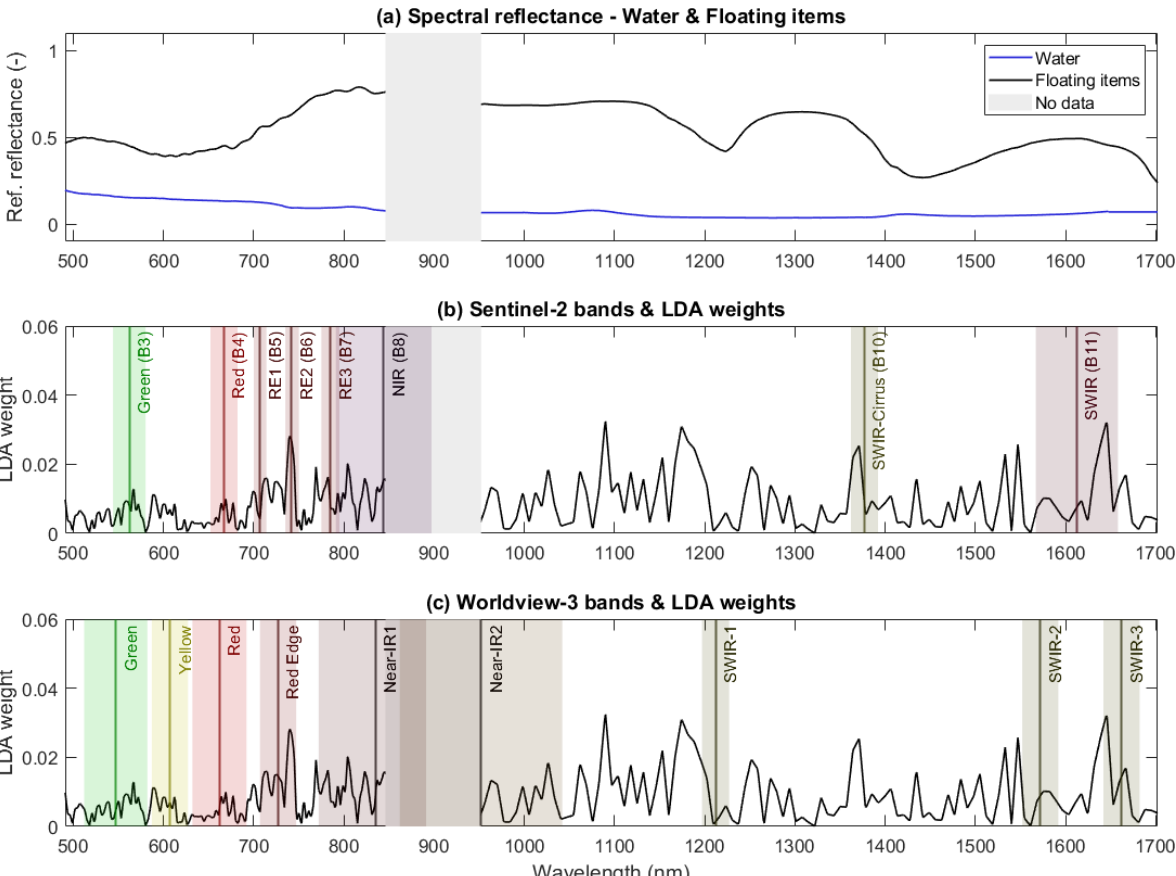
Figure 5. Reflection spectra of water and floating items ( a ); weights of the LDA separating water and floating items overlaid with central wavelengths and bandwidths of the Sentinel-2 MSI ( b ); and overlaid with central wavelengths and bandwidths of Worldview-3 MS-VNIR and MS-SWIR ( c ).